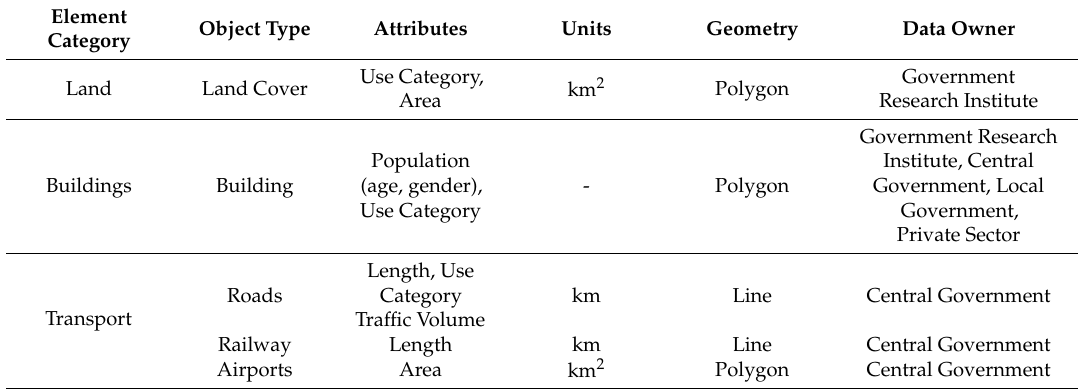
Table 1. Built-environment elements at risk and contextual